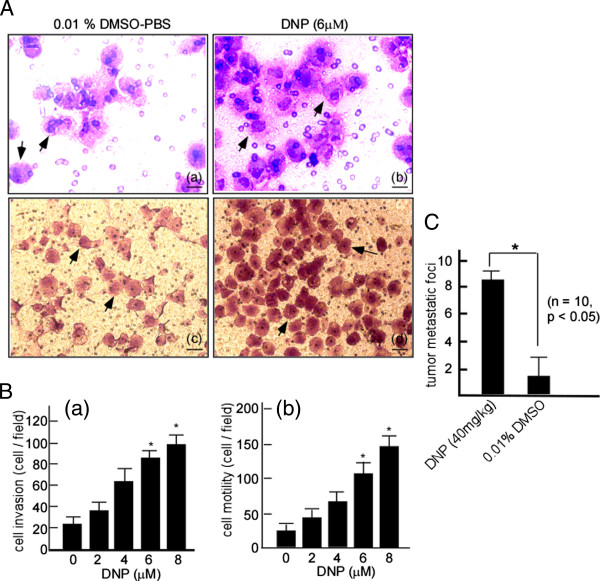
DNP-induced NPC cell metastasis in vitro and vivo. A, To determine DNP-induced invasion and motility, a Matrigel-coated Boyden chamber was used to measure 6-10B cell invasion, and an uncoated chamber for measuring cell motility. The cells invading to the lower surface of Boyden chamber membrane were fixed with methanol and stained with hematoxylin and eosin. a, 6-10B treated with 0.01% DMSO-PBS in Matrigel-coated Boyden chamber; b, 6-10B cells treated with DNP (6 μM) in Matrigel-coated Boyden chamber; Scale bar, 5 μm; c, 6-10B cells treated with 0.01% DMSO-PBS in the uncoated chamber; d, 6-10B cells treated with DNP in the uncoated chamber. Scale bar, 10 μm. Arrows, The invading cells. B, In concentration-course assays, 6-10B cells were treated with 2, 4, 6, and 8 μM DNP for 24 h. The motility and invasion of the treated cells were analyzed. Random fields were counted to determine the number of invaded cells under a light microscope. a, Invasion of 6-10B cells at various concentrations; b, Motility of 6-10B cells at various concentrations. The results were statistically analyzed by one-way analysis of variance (ANOVA) with post-hoc Dunnett’s test (*, p < 0.05). C, In animal experiments, 20 nude mice were randomly divided into 2 groups with 10 mice per group. One group was injected with DNP-treated 6-10B cells in Matrigel through the tail vein (1 × 104 cells/mouse). The other group was injected with untreated 6-10B cells. After 60 days, metastatic tumors nodes in the lungs were observed under the microscope (*, p < 0.05).